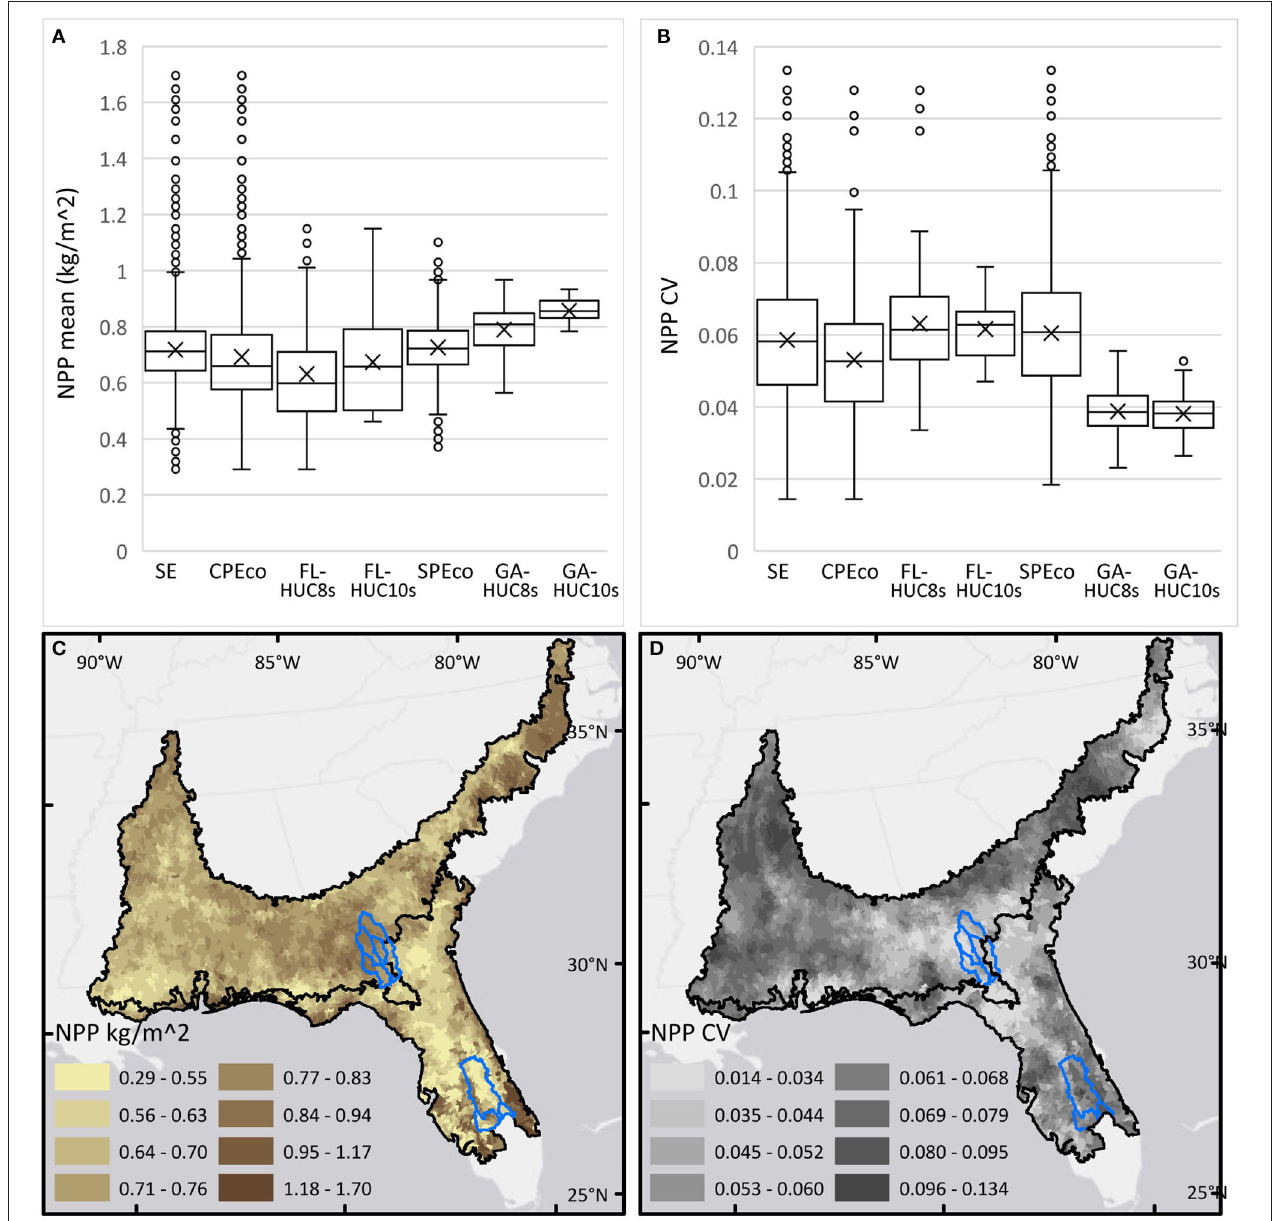
FIGURE 6 | Boxplots and maps of net primary production (NPP, kg C/m 2 ) and coefficient of variation (CV%) average annual mean values, 2014–2018, calculated for HUC-12 areas and summarized for each study area (clockwise from top left). (A) Boxplots of NPP for each study area. (B) Boxplots of NPP CV for each study area. (C) Map of NPP calculated for HUC-12s in the Southeast (SE). (D) Map of NPP CV calculated for HUC-12s in the Southeast (SE). Blue outlines show HUC-8 areas. FG2) means there is a higher proportion of contiguous